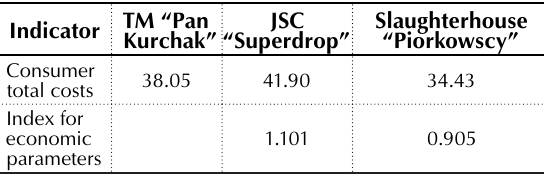
Table 2. The results of calculation of the group index for economic parameters